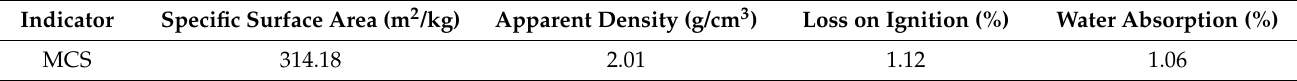
Figure 2. The particle distribution of MCS. Table 3. The physical characteristics of MCS.